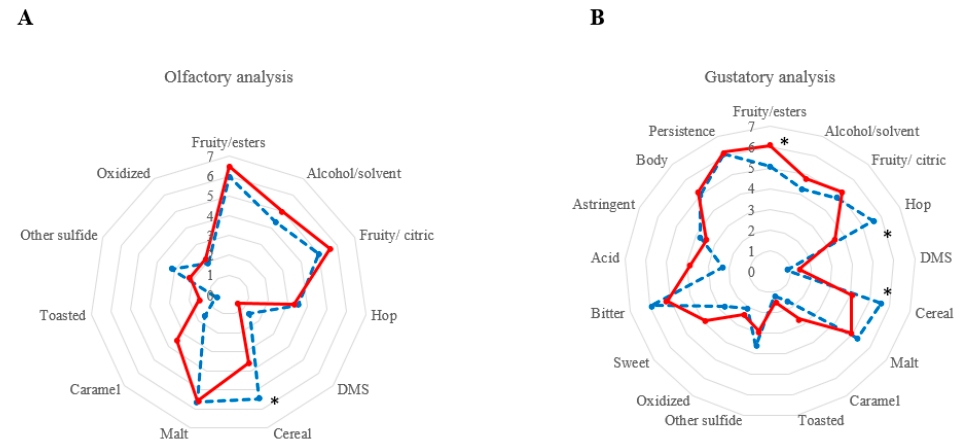
Figure 2. Sensory analysis of beer produced in the microbrewery plant by the T. delbrueckii mixed fermentation. From pure cultures of S. cerevisiae ( ) and mixed cultures of S. cerevisiae / T. delbrueckii (